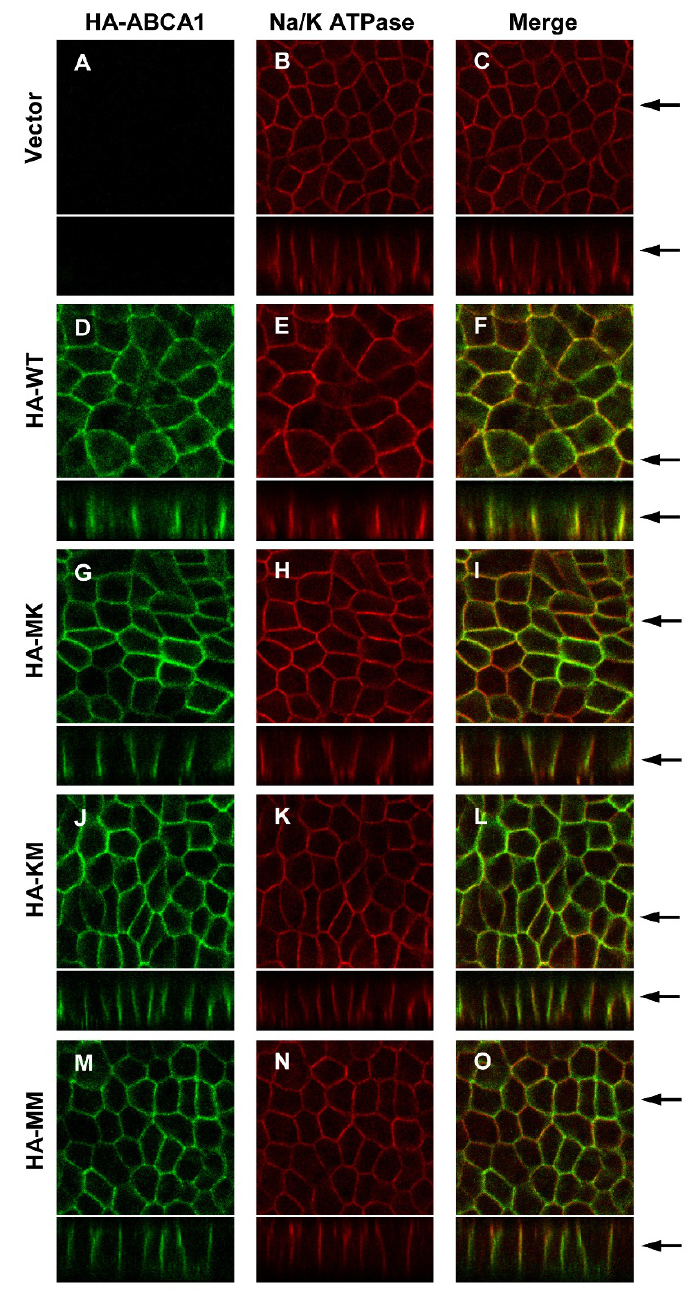
Figure 5 Subcellular localization of HA-tagged ABCA1 variants in polarized MDCKII cells . MDCKII cells expressing the wild type (D-F) or mutant variants (G-O) of HA-ABCA1 were grown on a permeable membrane support to form polarized cul- tures. As a negative control, cells transduced with the neo-containing vector (see Figure 1) were used (A-C). HA-ABCA1 vari- ants were visualized by immunofluorescent staining of permeabilized cells, using confocal microscopy. ABCA1 protein detected by anti-HA antibody is shown in green; staining of Na + /K + ATPase (red) served as a basolateral plasma membrane marker. Right panels depict the overlay. Cross sections are shown at the bottom of each panel; arrows at the side indicate the position of the presented xz and xy planes. All HA-tagged ABCA1 variants exhibited similar and clear basolateral plasma membrane localiza- tion, showing only a low level intracellular